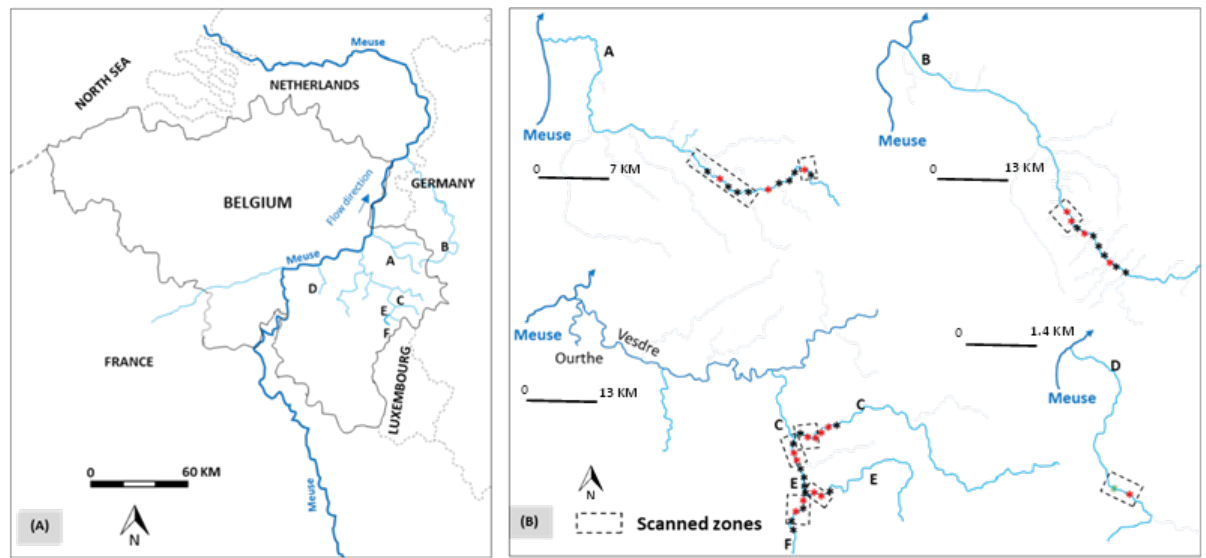
Figure 1. Location of the study sites in Southern Belgium ( A ) and the morphology of the scanned areas ( B ). * in black indicates glass eel release sites. * in red indicates fishing and tagging eel sites. * in green indicates unrelease site of glass eels. The rivers are A , B , C , D , E and F .